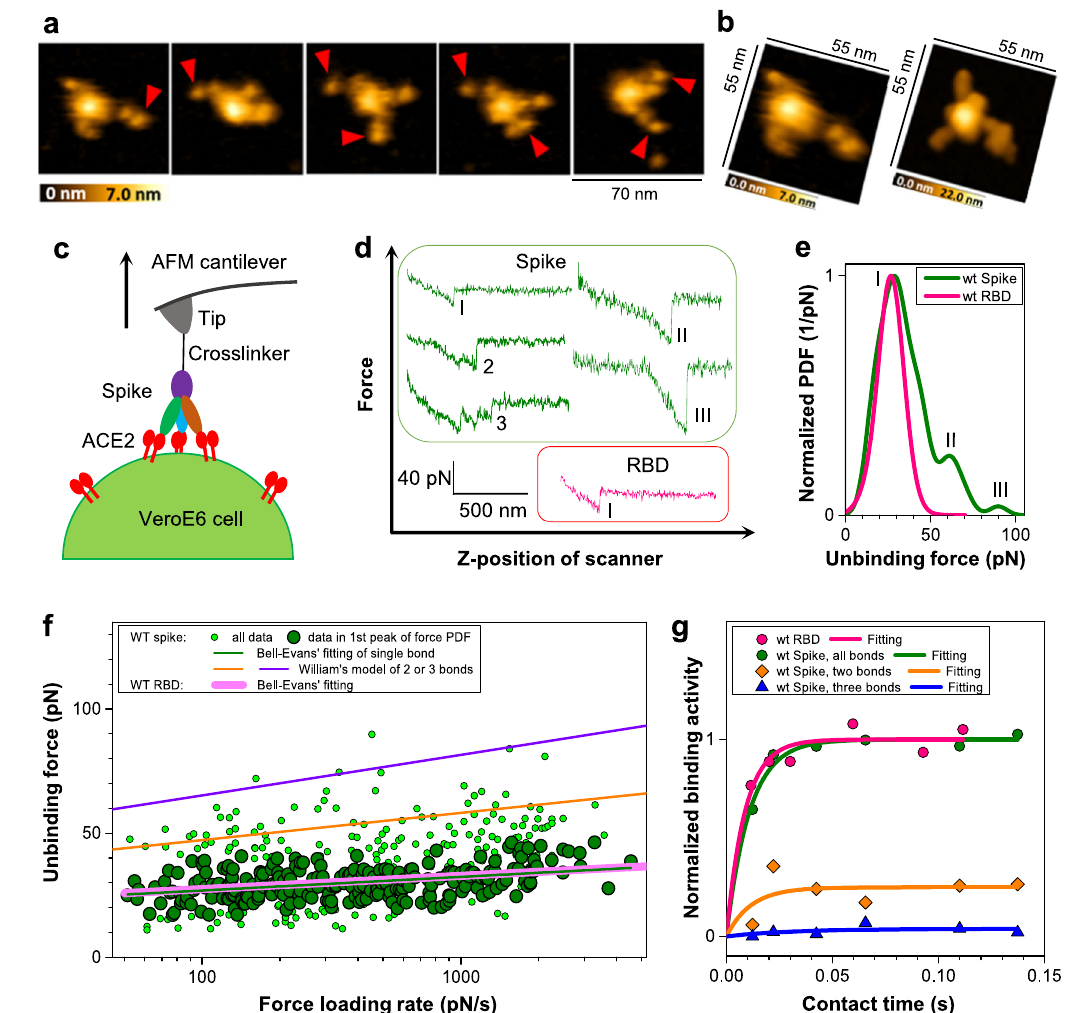
Fig. 2 | Binding of the Wuhan-1 reference strain Spike trimer and monomeric RBDtoACE2.a SpiketrimerincomplexwithoneortwoACE2dimers(indicatedby redarrows). b AFMimage(left)andsimulationusingMDSmodeling(right)ofSpike trimer bound to one ACE2. c Schematic illustration of single-molecule force spec- troscopy experiments, in which dissociation forces between the Spike trimer (or RBD) on AFM tips and membrane-anchored ACE2 expressed on VeroE6 cells were measured. d Exemplary force – distance curves from the experiments. The Spike trimer (green lines) exhibits up to three interactions per force curve. Multiple bonds either break sequentially ((2) and (3)) or simultaneously ((II) and (III)). Monomeric RBD shows only one interaction per force curve (red line). e Experimentalprobabilitydensityfunctions(PDF)ata fi xedpullingvelocity.Force maxima for the Spike trimer (green curve) correspond to the simultaneous dis- sociation of one (I) two (II) or three (III) bonds. Monomeric RBD (red curve) shows only one force maximum, re fl ecting the dissociation of a single bond. f Dynamic